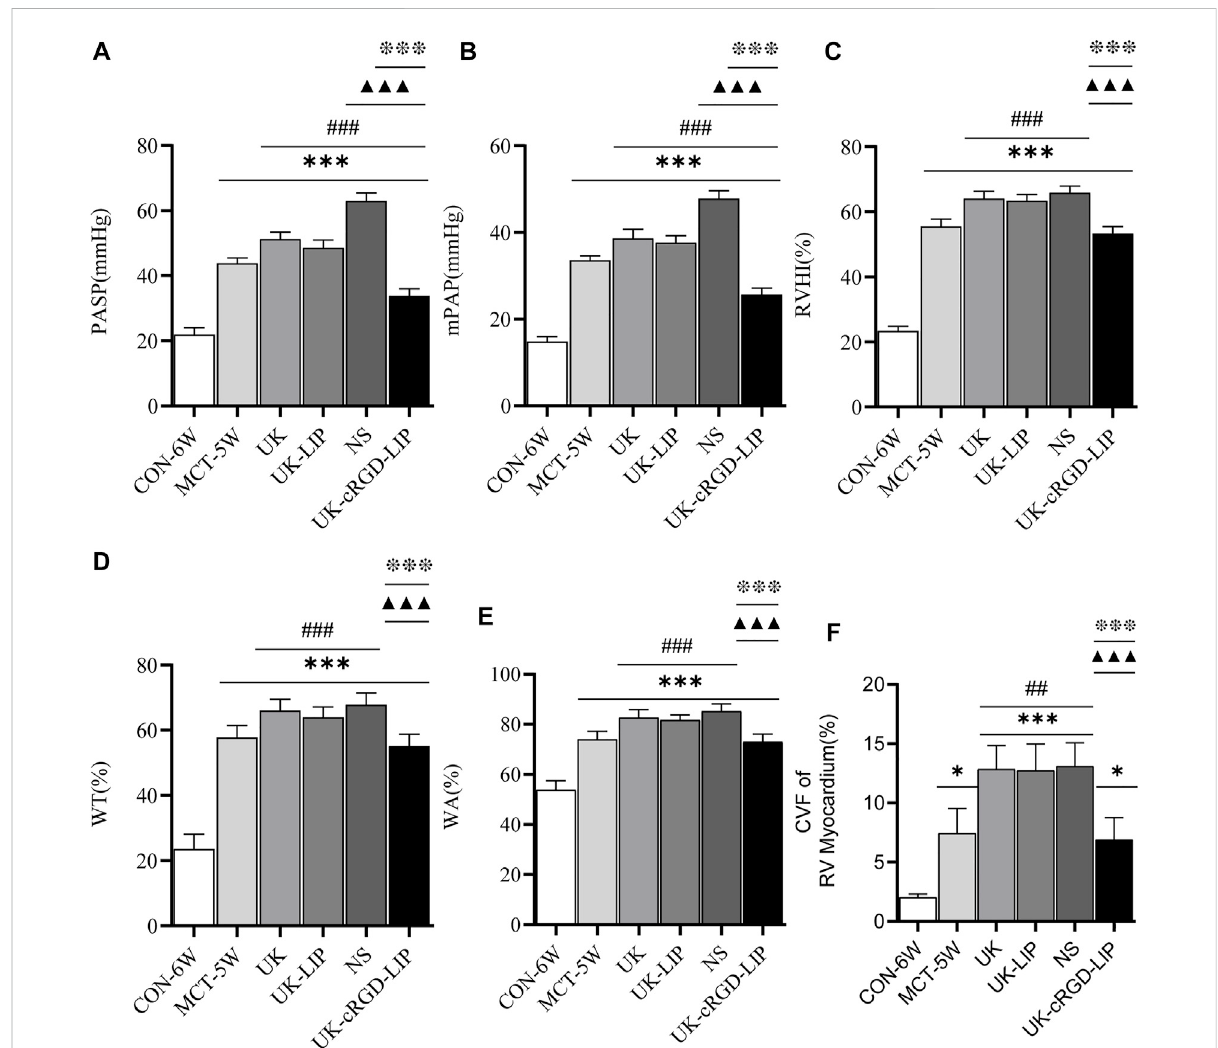
FIGURE 7 Reduction of in-situ thrombi in pulmonary arterioles alleviates the progression of MCT-induced PH in rats. (A) Pulmonary artery systolic pressure was measured in CON-6W, MCT-5W, UK, UK-LIP, NS, and UK-cRGD-LIP rats. (B) Mean pulmonary artery pressure was measured in CON- 6W, MCT-5W, UK, UK-LIP, NS, and UK-cRGD-LIP rats. (C) Quantitative analysis of right ventricular hypertrophy index. (D) Quantitative analysis of vascular wall thickness. (E) Quantitative analysis of vascular wall area. (F) Quantitative analysis of fi brotic area. Values were presented as Mean ± SD. Data (CON-6W, n = 10; MCT-5W, n = 9; UK, n = 8; UK-LIP, n = 8; NS, n = 8; UK-cRGD-LIP, n = 9) were analyzed by one-way ANOVA (A – E) or Kruskal – Wallis test (F) . * p < 0.05 and *** p < 0.001 vs. CON-6W; ## p < 0.01 and ### fn ### p < 0.001 vs. MCT-5W; ▲▲▲ p < 0.001 vs. UK or UK-LIP; ❉❉❉ p < 0.001 vs.